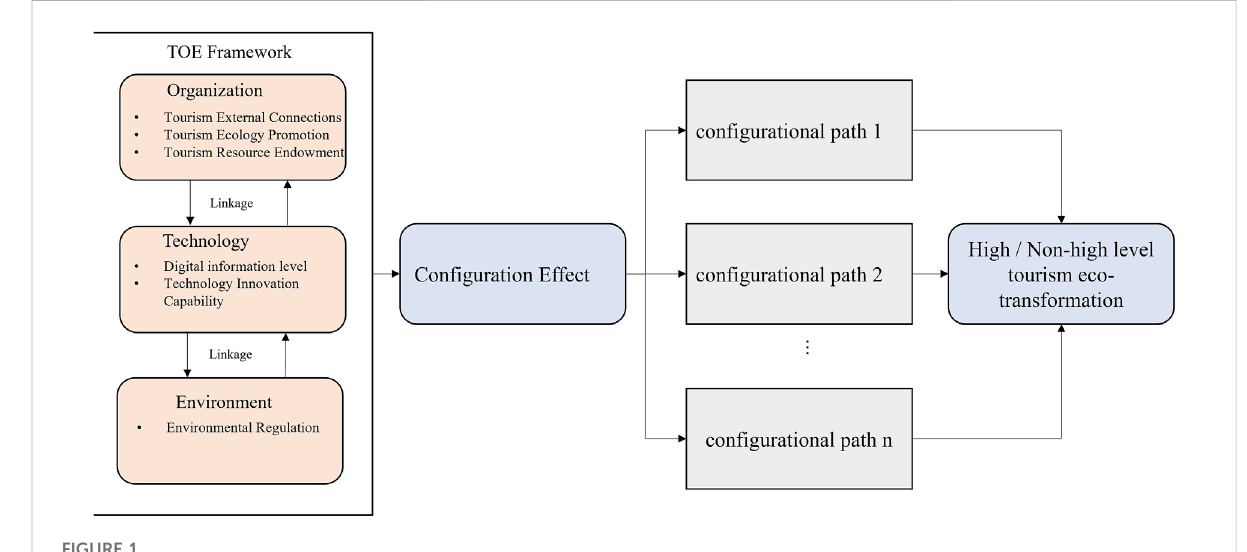
FIGURE 1 TET con fi gurational